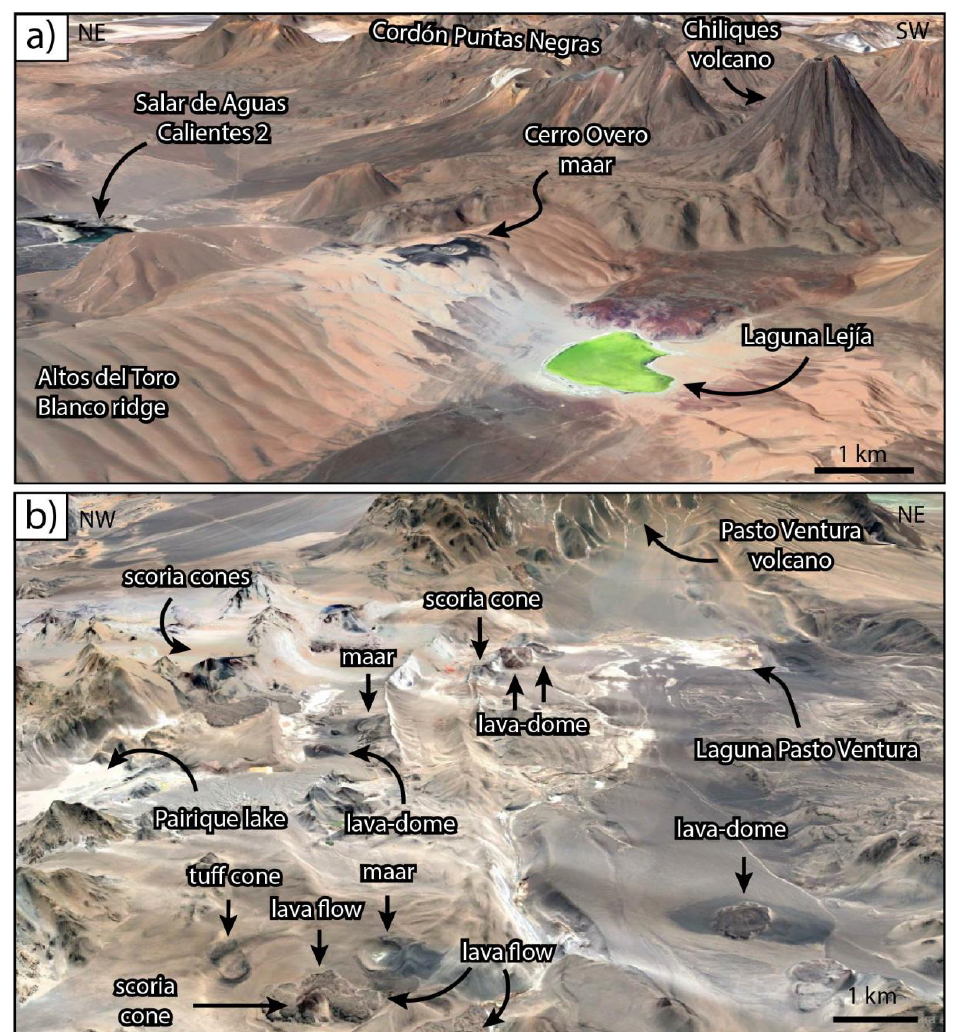
Figure 11. Examples of scenarios that permit and favor the growth mechanisms for maar formations are characterized by the presence of ridge structures and flux of groundwater evidenced by the occurrence of lakes. ( a ) Cerro Overo area, northern Chile. ( b ) Pasto Ventura monogenetic volcanic field, Puna Argentina. Satellite images are taken from Google Earth TM .